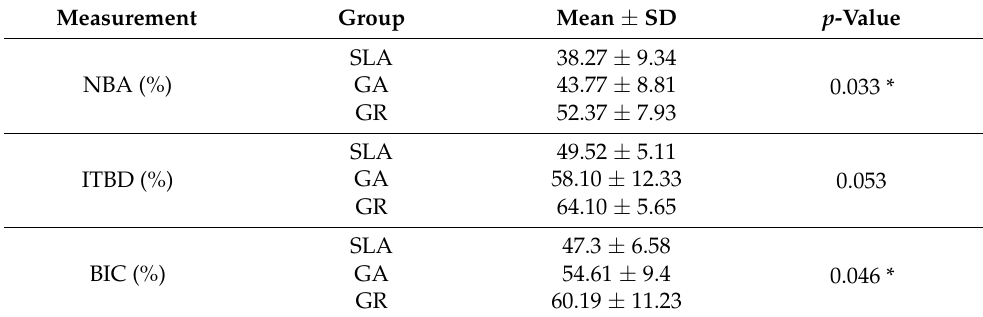
Table 2. Mean values of new bone areas (NBAs), inter-thread bone densities (ITBDs), and bone to implant contacts (BICs) as determined by histometric analysis.